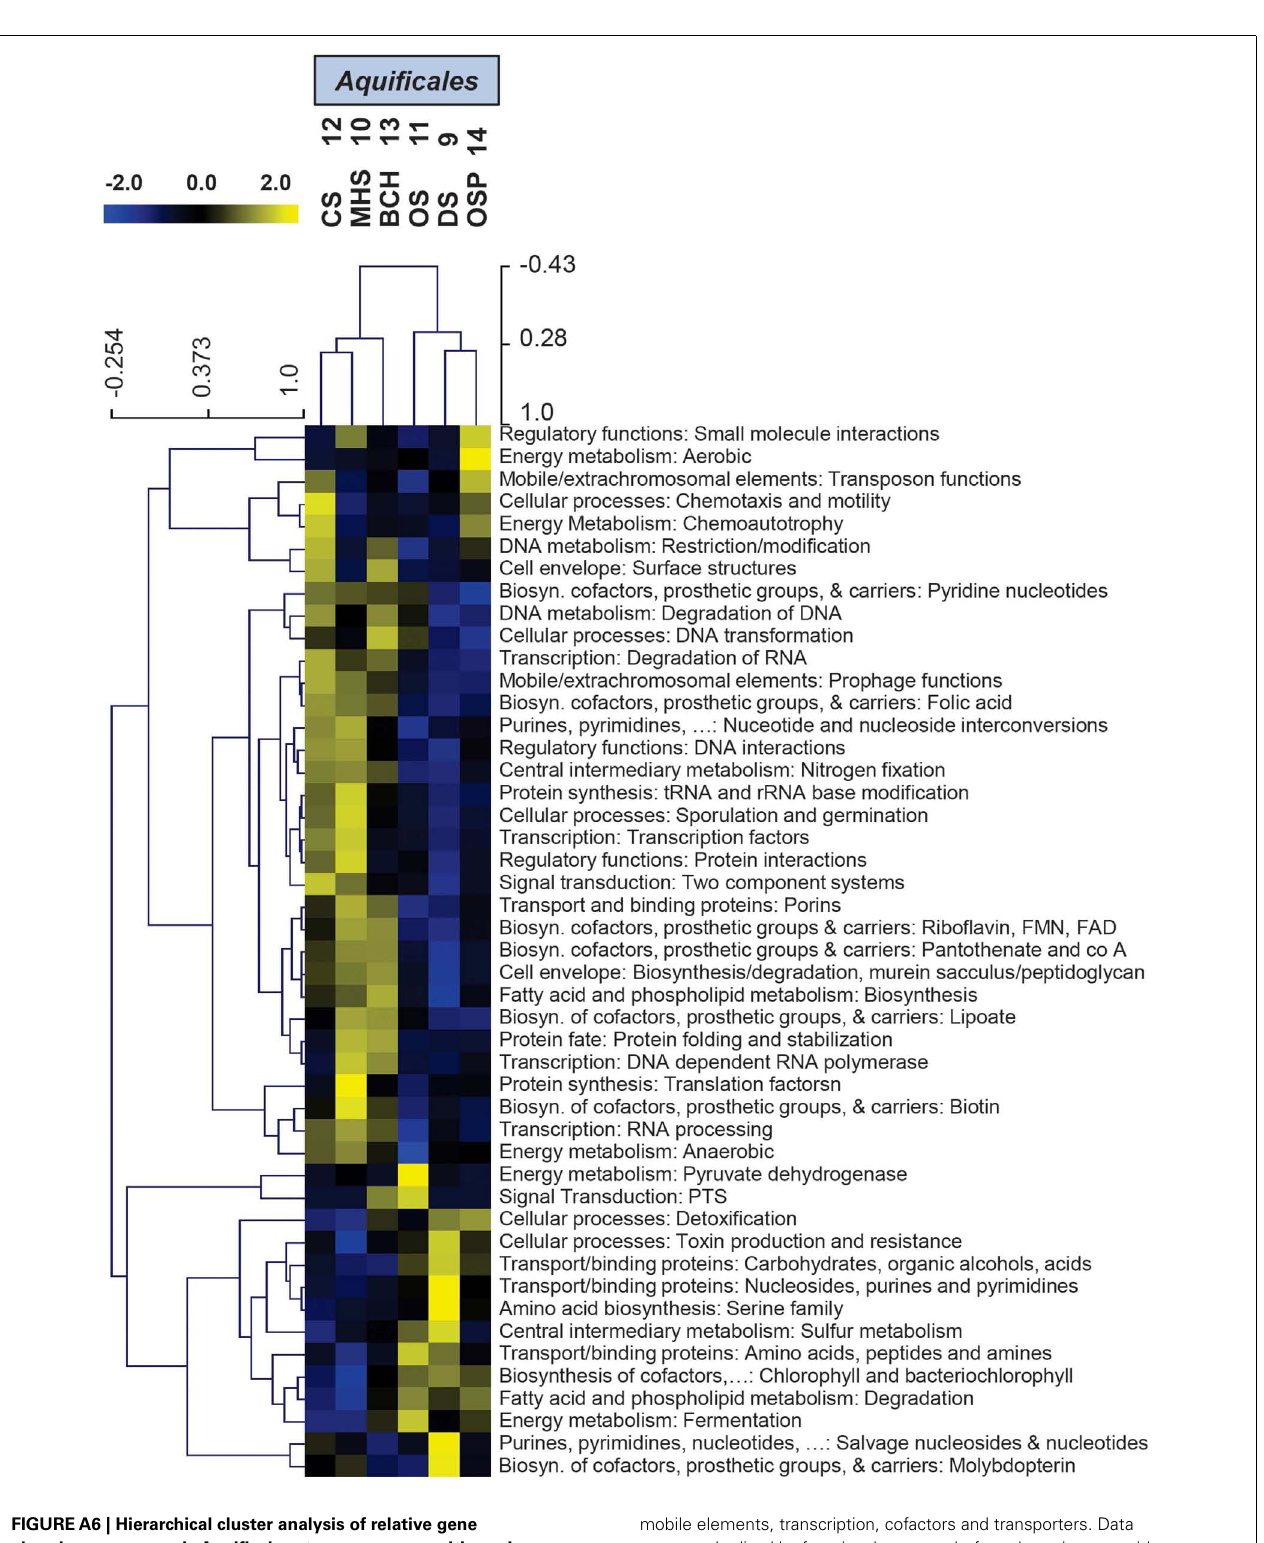
FIGUREA6 | Hierarchical cluster analysis of relative gene abundances across sixAquificales streamer communities using allTIGRFAMs grouped into functional categories . Broad TIGRFAM categories include all cellular processes such as regulatory functions, energy metabolism, central C metabolism,